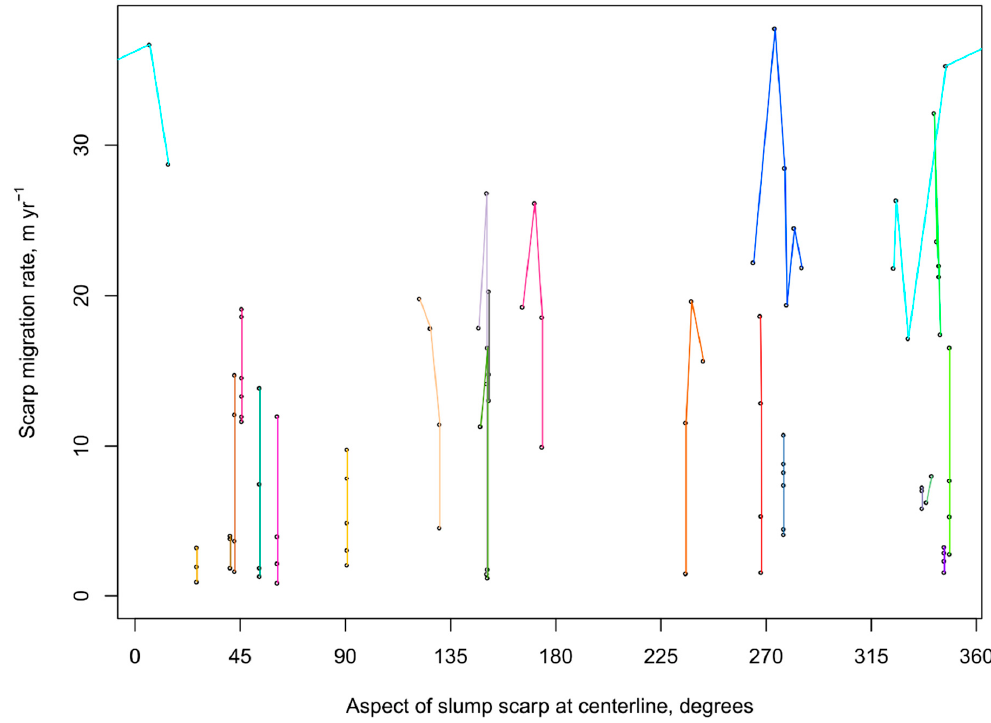
Figure 11. Scarp migration rate vs. orientation of the scarp. Scarp migration rates for sequential observation dates of a single slump are connected by lines of a single color.